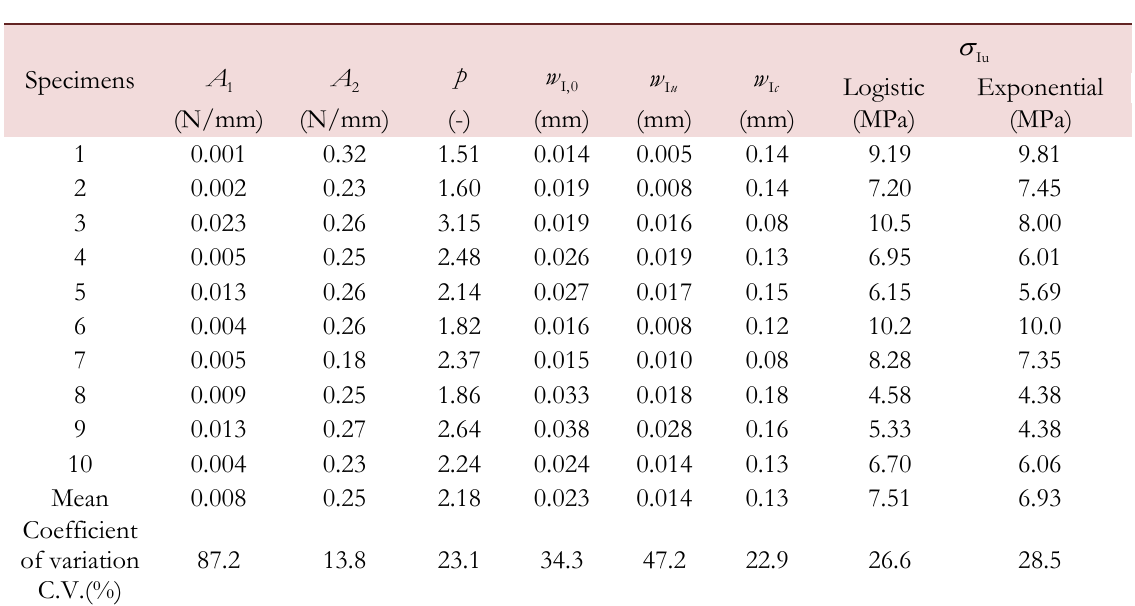
 ) and relative Iu